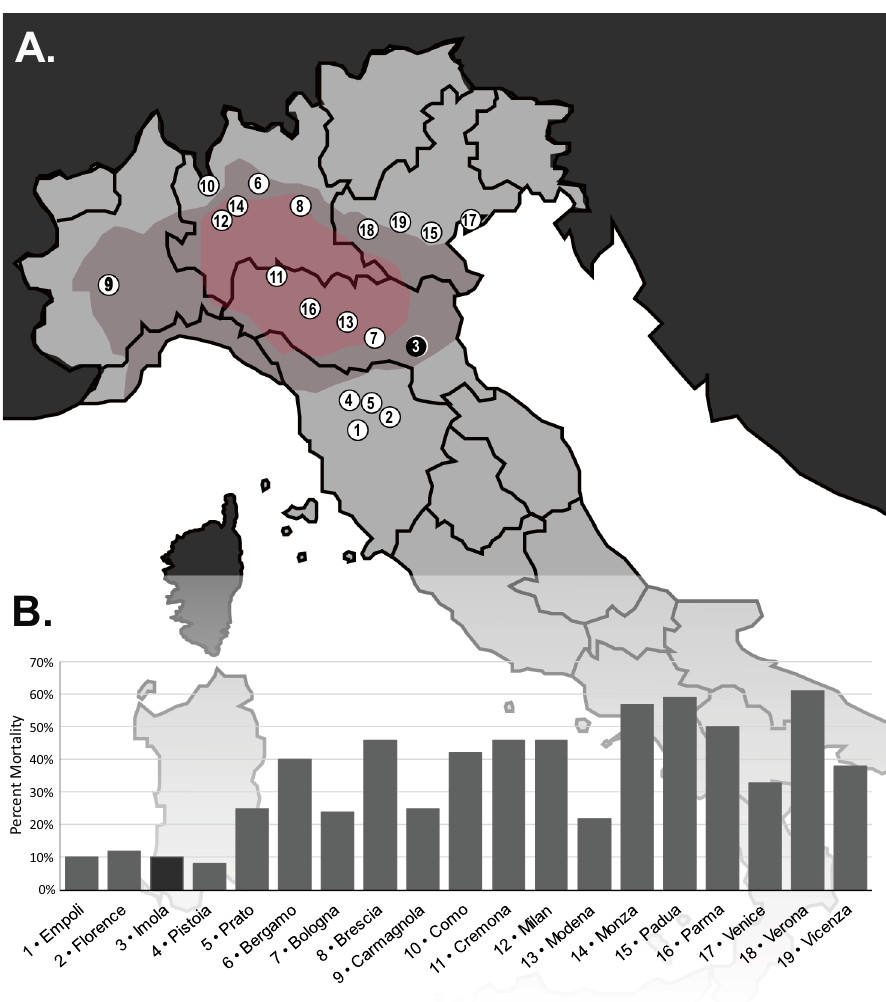
Figure 1. The plague of 1630–1632 in Northern and Central Italy. ( A ) Map of Northern and Central Italy showing the cities recorded on ( B ). Areas known to have been affected by the famine of 1628–1629 are marked in red and areas speculated to have been affected in grey-red. The site of Imola is marked in black. Vector basemap from Wikimedia Commons (Carte ITALIE R1, 2018). ( B ) Mortality rates for cities marked in ( A ) (as reported in Cipolla 2012). The mortality rate for the city of Pistoia was revised according to the data detailed in Cipolla 1981. (The vector basemap was modified from “Carte ITALIE R1” by Wikisoft on Wikimedia Commons 5 licensed under CC BY-SA 3.0